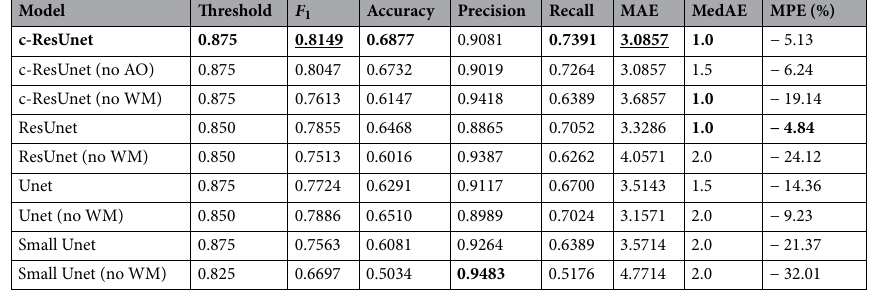
Table 1. Performance metrics computed on the test set using the optimal kneed threshold. The first four columns report the detection metrics, while the latter ones evaluate counting performance. The best scores for each metric are reported in bold, with underline to highlight the main indicators of interest.